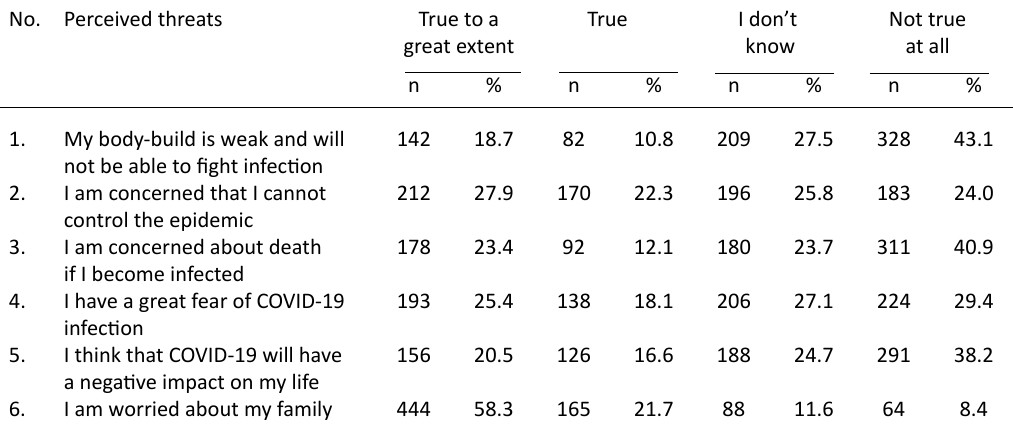
table 2. Percent distribution of the study participants according to their perceived threat scores (n=761)